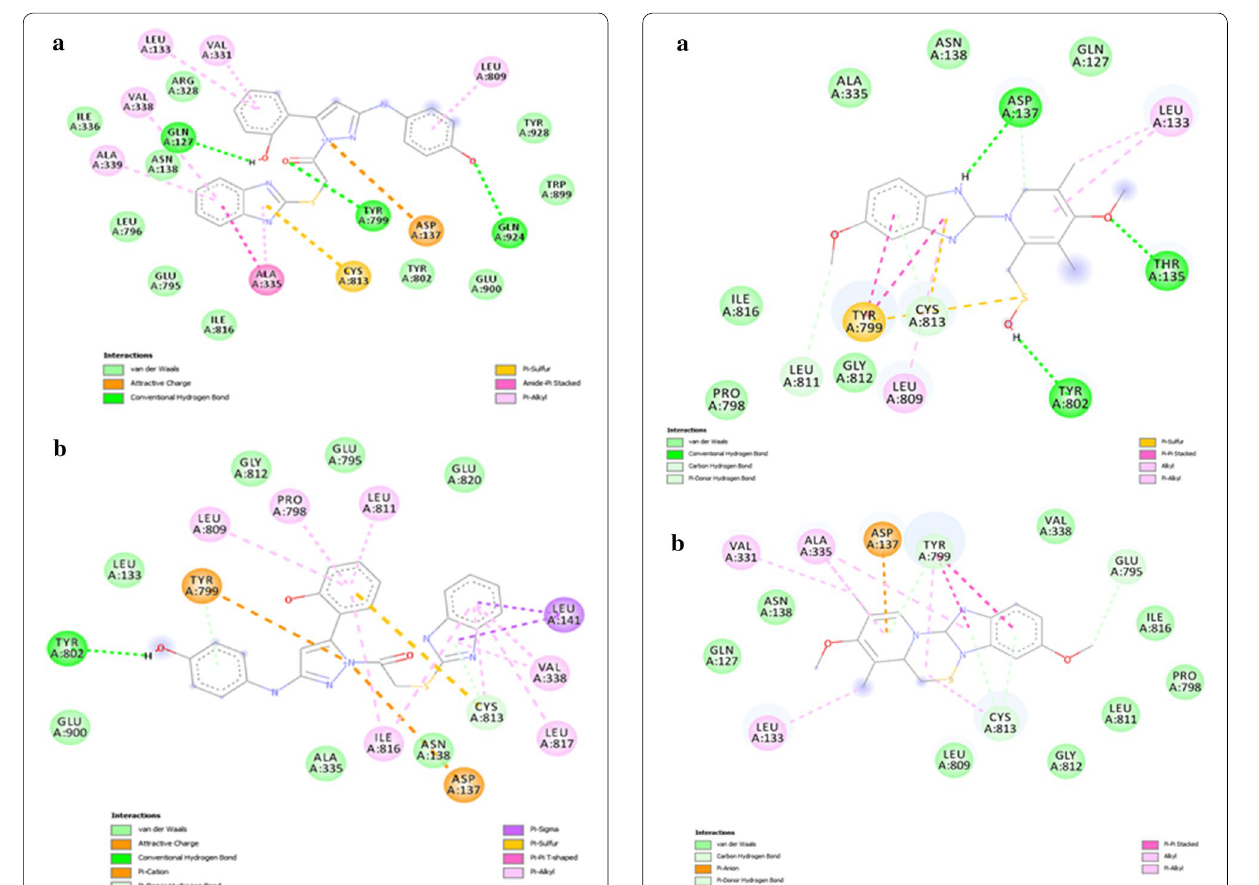
Fig. 9 Predicted interactions of 5e ( a ) and 5f ( b ) with active